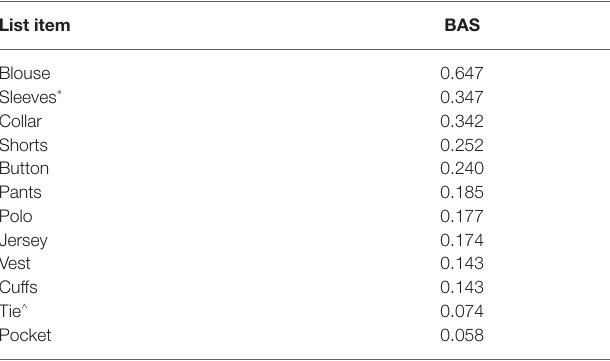
TABLE 1 | Example study list items and backward associative strength (BAS) values for the critical lure “Shirt” with strongly and weakly related lures in Experiments 1 and